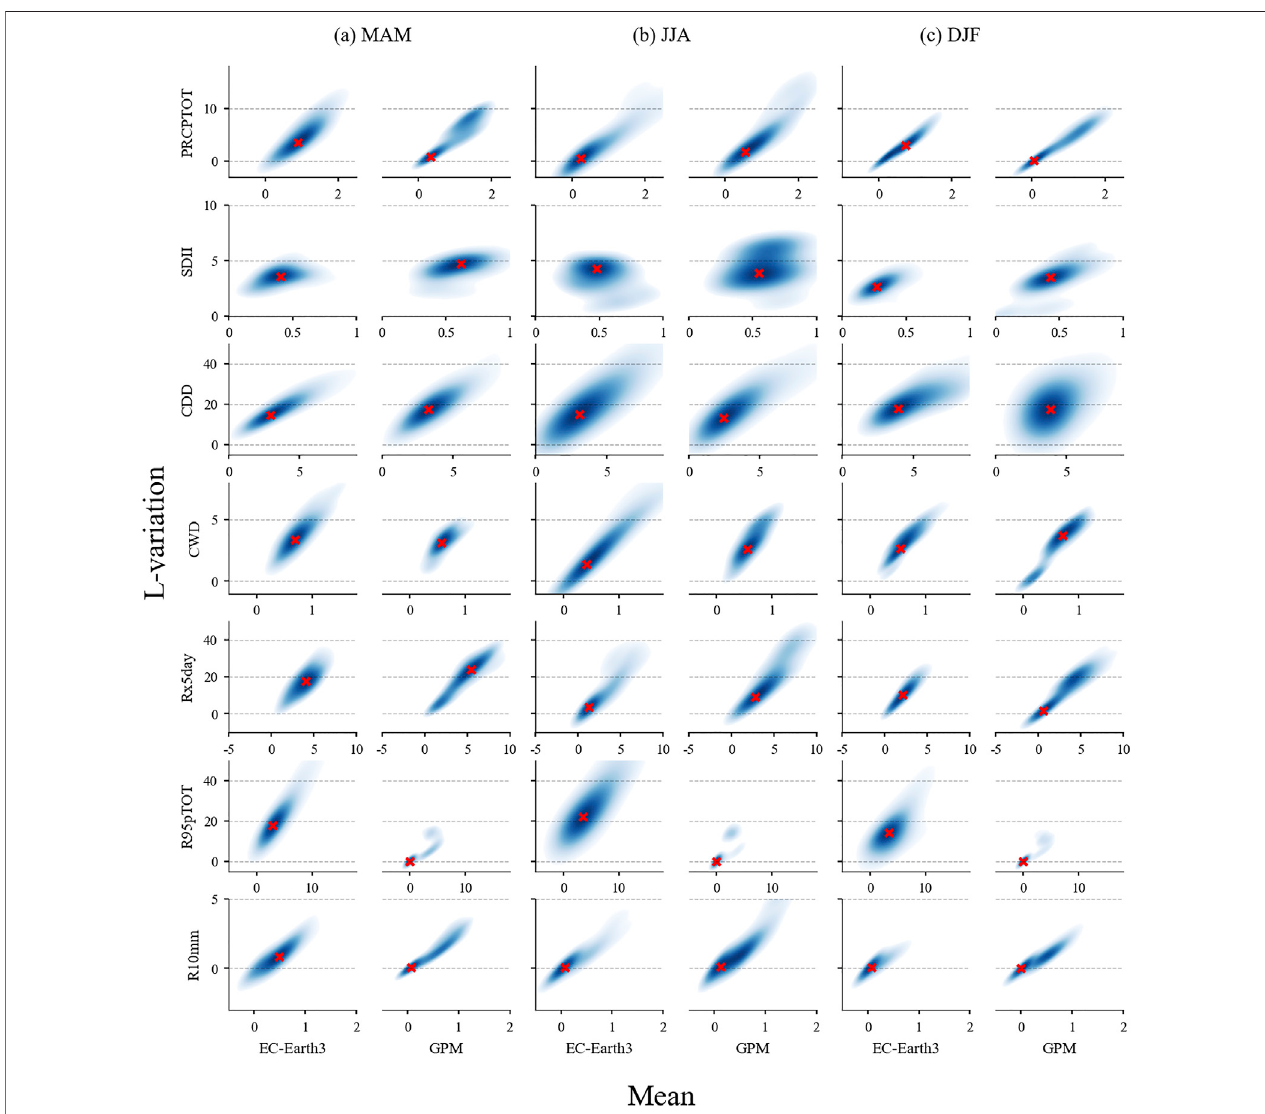
FIGURE5| KernelbivariatedensitiesforasimulationofEC-Earth3andGPMwiththehighestprobableregionofmeanandL-variationdensitiesin (A) spring(MAM), (B) summer (JJA), and (C) winter (DJF). The red cross represents the highest probability region.